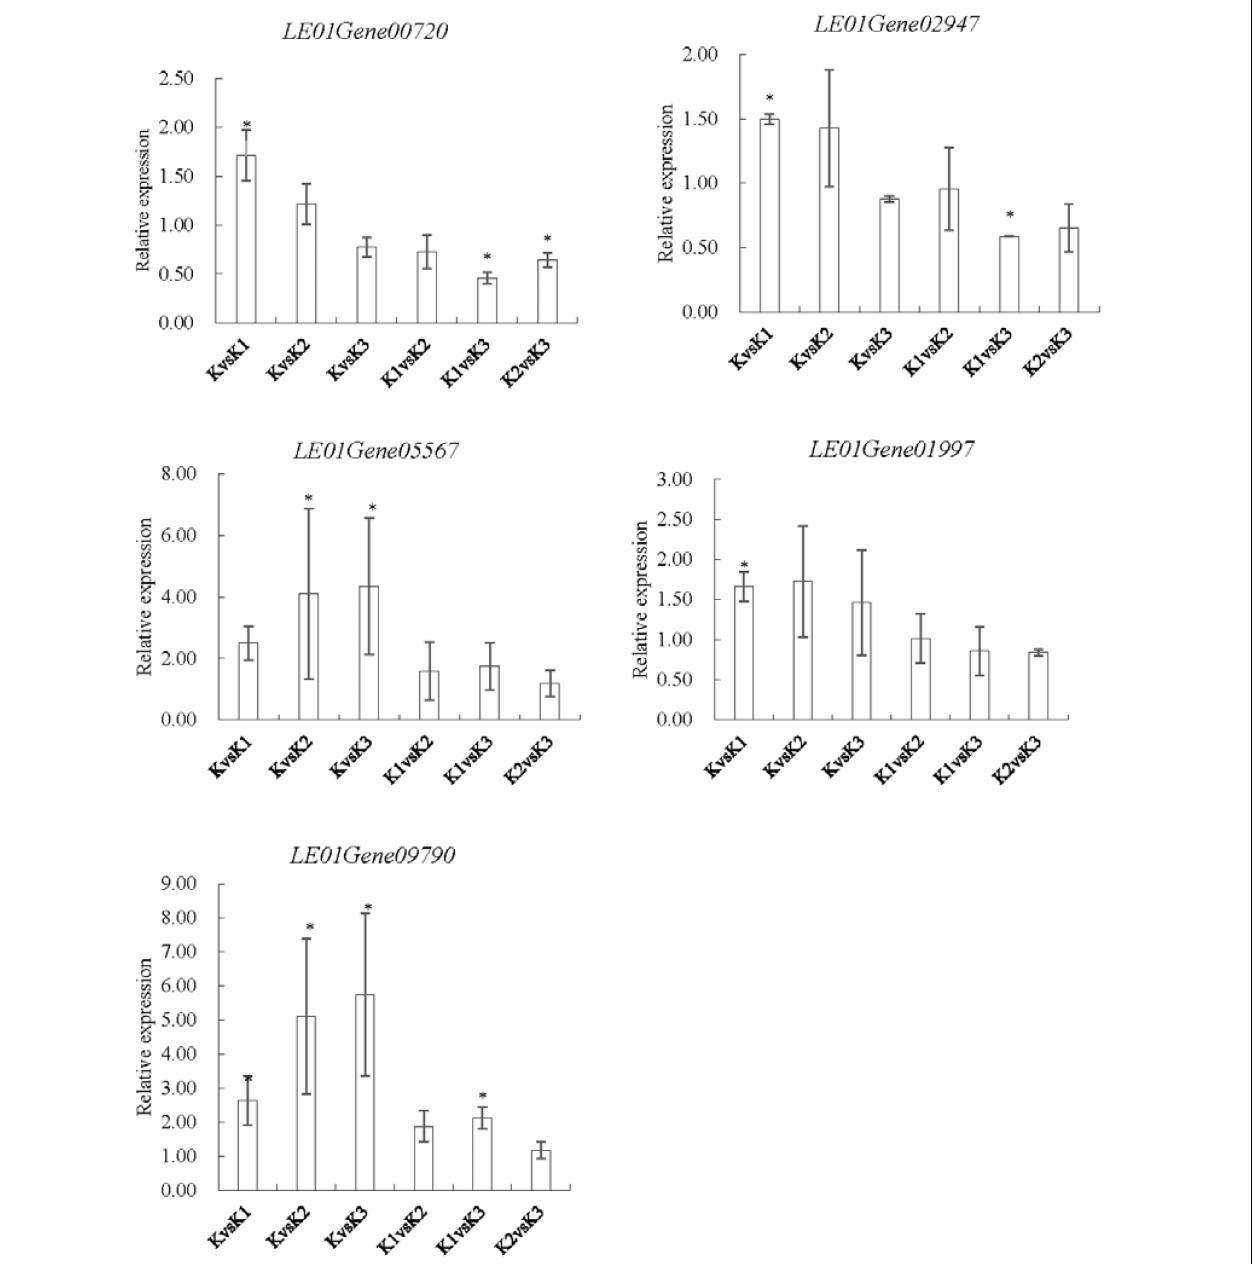
FIGURE 10 | qRT-PCR analysis of five genes encoding enzymes related to the LEFP30 biosynthesis in L. edodes . LE01Gene00720 and LE01Gene02947 encoding 1,3- β -glucan synthase, LE01Gene05567 encoding glucose-6-phosphate isomerase, LE01Gene01997 encoding UDP-glucose pyrophosphorylase, and LE01Gene09790 encoding phosphoglucomutase. ∗ p < 0.05, the expression of the unigene was significantly upregulated or downregulated in the treatment group,